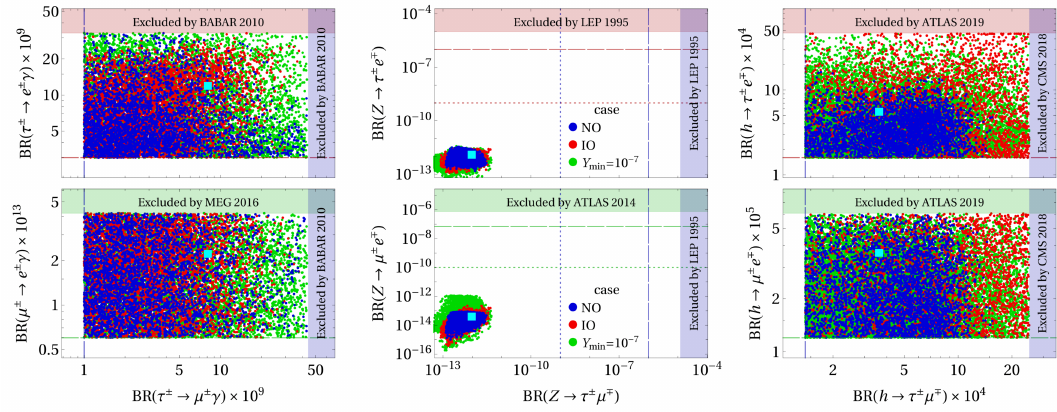
Figure 8 . Scatter plots of the branching ratios for three different fits. Blue points have normal ordering of the light-neutrino masses, red points have inverted ordering, and green points have a lower bound ( 10 − 7 instead of 10 − 6 ) on the moduli of the Yukawa couplings. A cyan square marks BP-1 of table 3. The shadowed bands are the present experimental upper bounds on the BRs; dashed and/or dotted lines show the future experimental sensitivities, as described in table